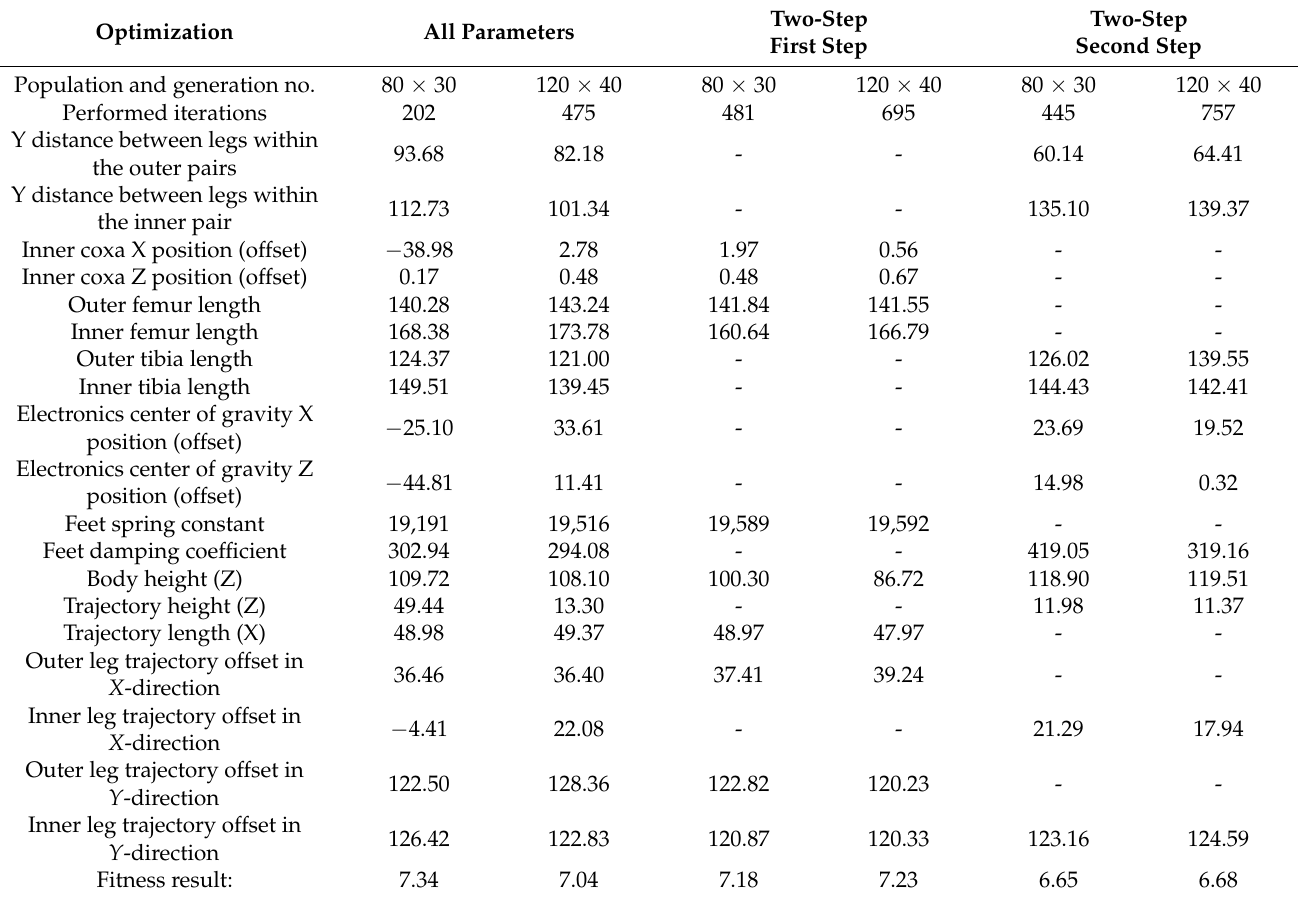
Table 7. Fitness results and optimization parameters for the 19-parameter optimization, the first step of the two-step optimization and the second step of the two-step